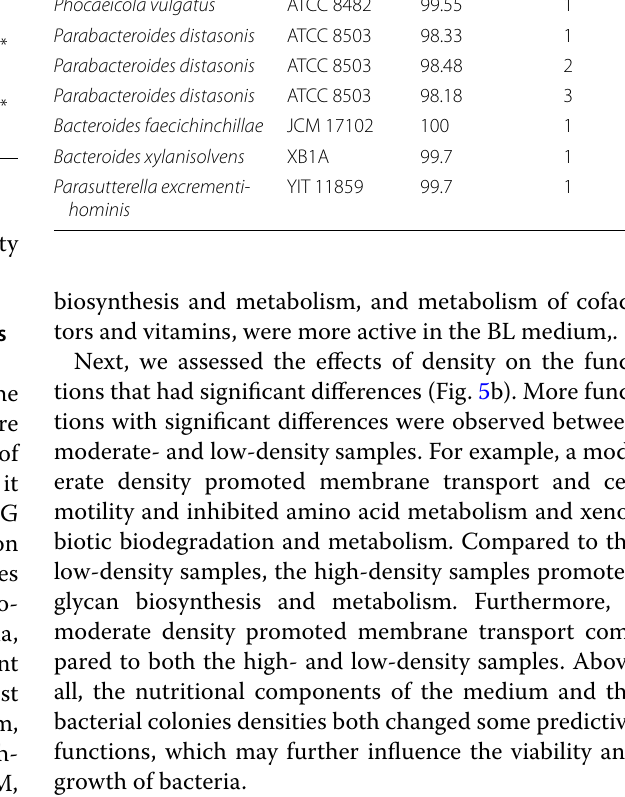
Table 3 Strain information of isolates from TSA medium Top‑hit taxon Top‑hit strain Similarity (%) Numbers